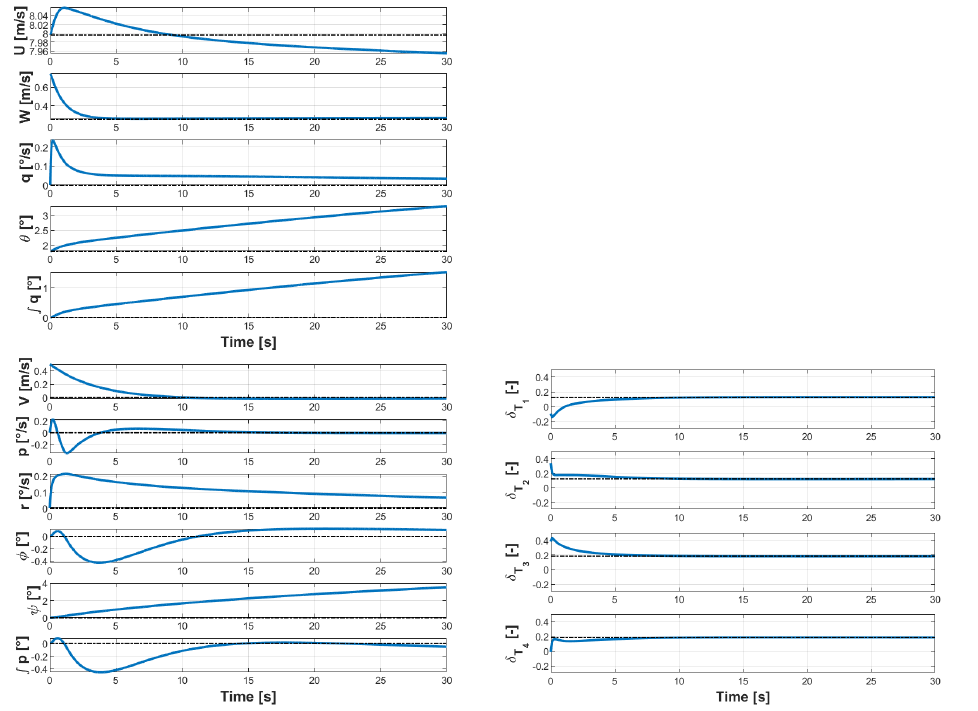
Figure 10. Time response of four-thrusters airship with thrust-based stabilizing control, in trimmed horizontal flight at a ground speed of 8 m/s, to an initial perturbation of ∆ W = ∆ V = 0.5 m/s. ( Top-left ) and ( bottom-left ) longitudinal and lateral-directional states. ( Bottom-right ) controls. Black dash-dotted lines: trimmed